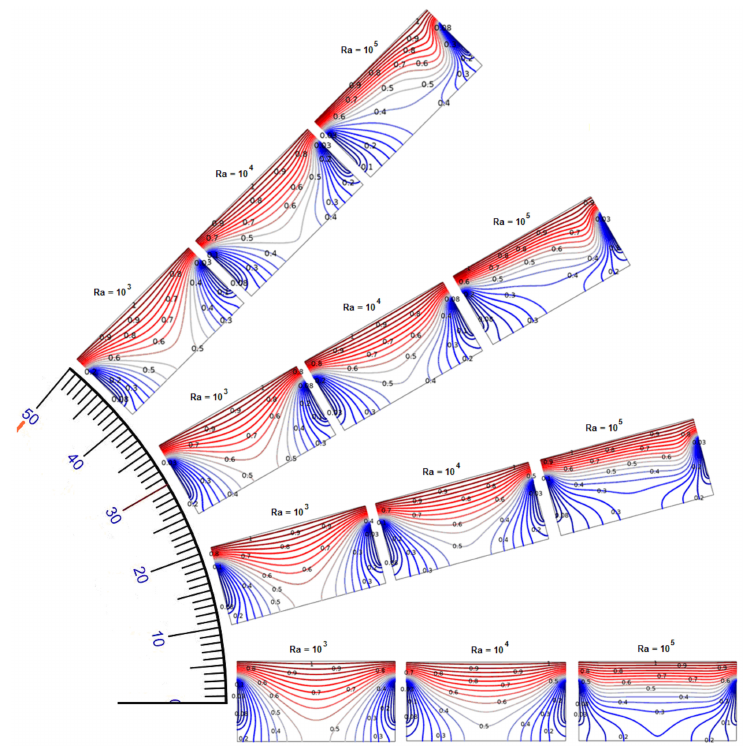
Figure 11. Effects of Rayleigh number and enclosure inclination angle on nanofluid